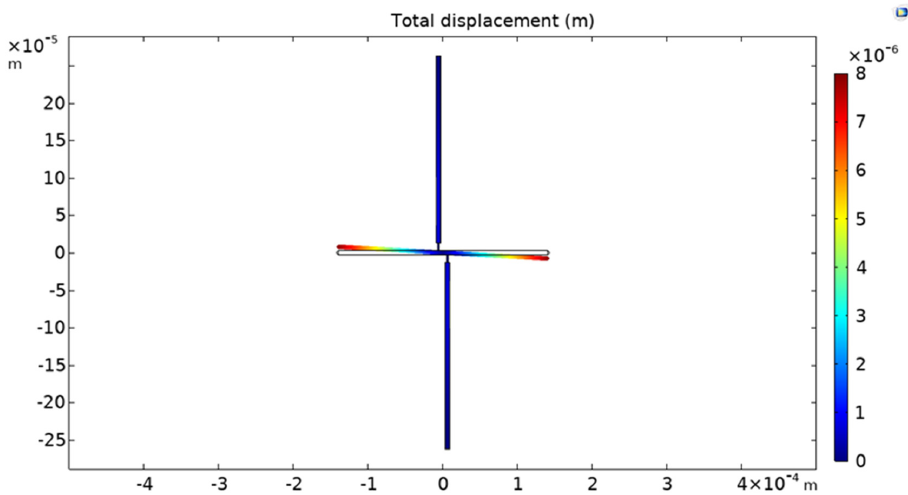
Figure 5. Strain gauge displacement simulated with COMSOL Multiphysics.